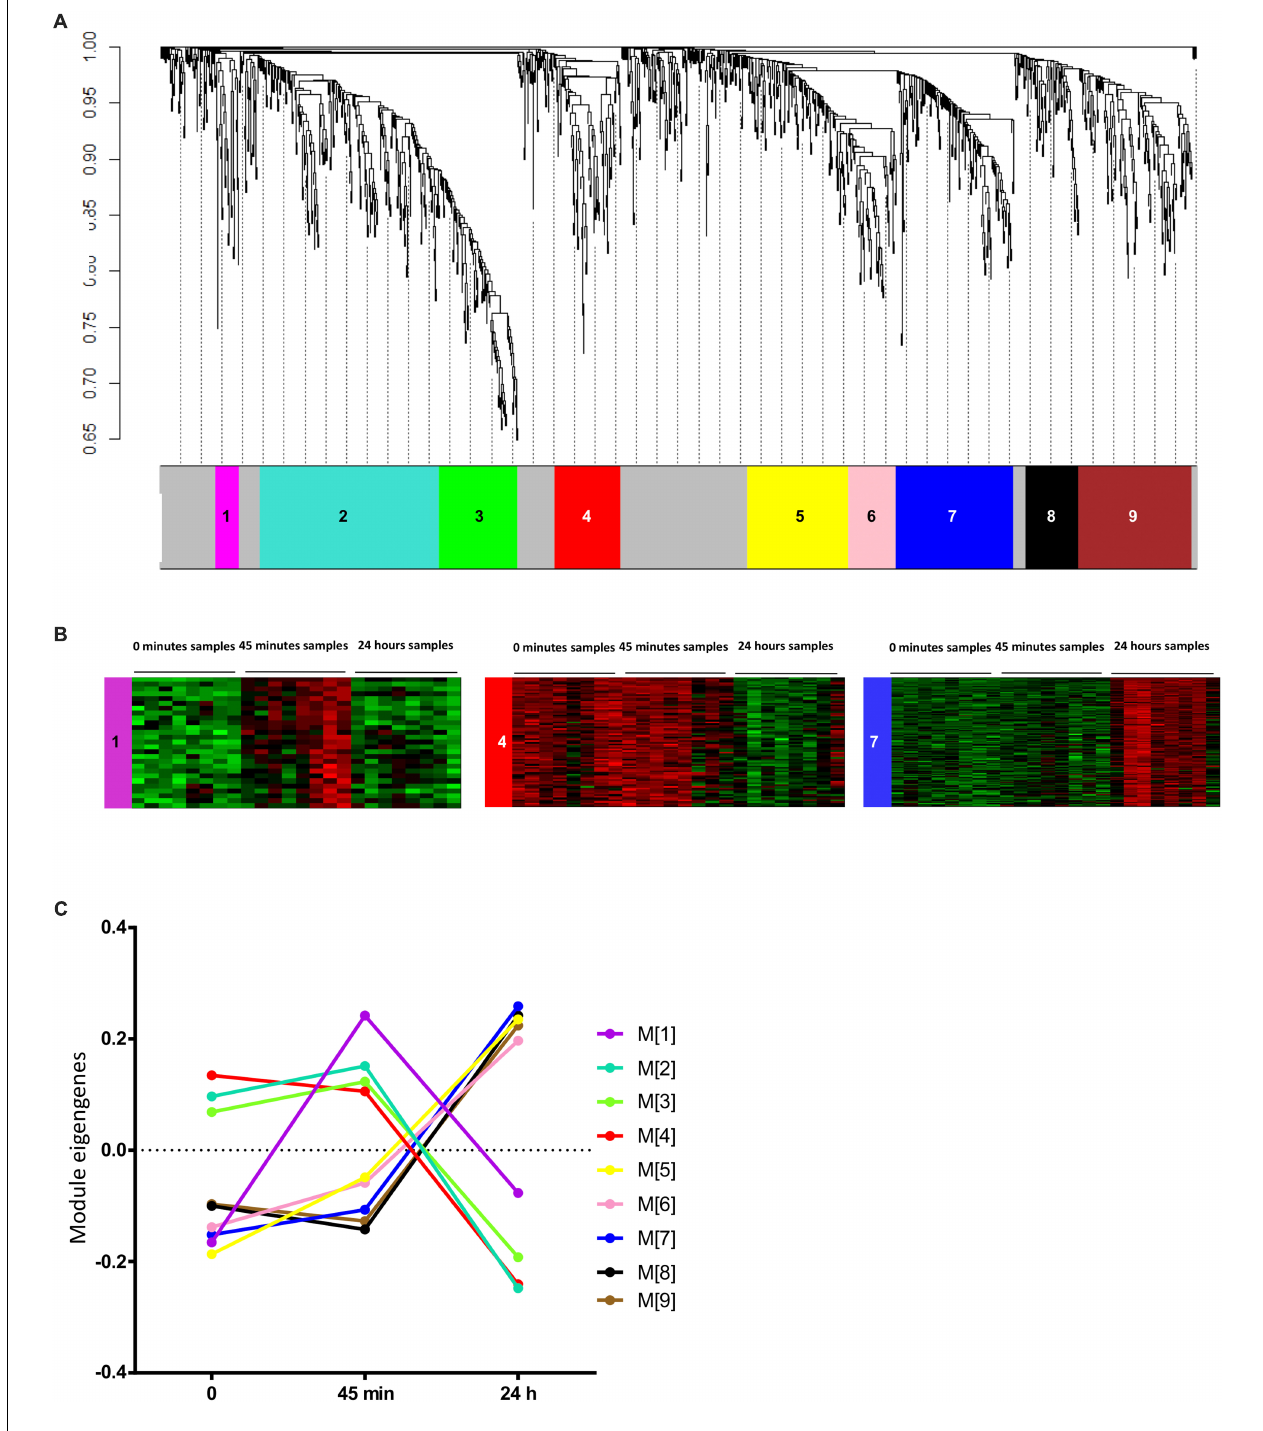
FIGURE 2 | Weighted gene co-expression network analysis. (A) Gene dendrogram representing the hierarchical clustering of transcripts based on their similarity in the expression profiles. Tree branches correspond to transcripts and colors underneath the tree corresponds to the modules assignment by Dynamic Tree Cut of the WGCNA package. (B) Heatmaps of the level of expression of transcripts assigned to examples of the three main time profile of transcripts expression: the magenta (M[1]), red (M[4]), and blue (M[7]) modules. Red color corresponds to higher expression and green color corresponds to lower expression. (C) Line graph representing the variation of the expression profiles in the different modules over time. Values represent the mean eigengenes figured out by WGCNA. The color code used is the same as in (A,B) .